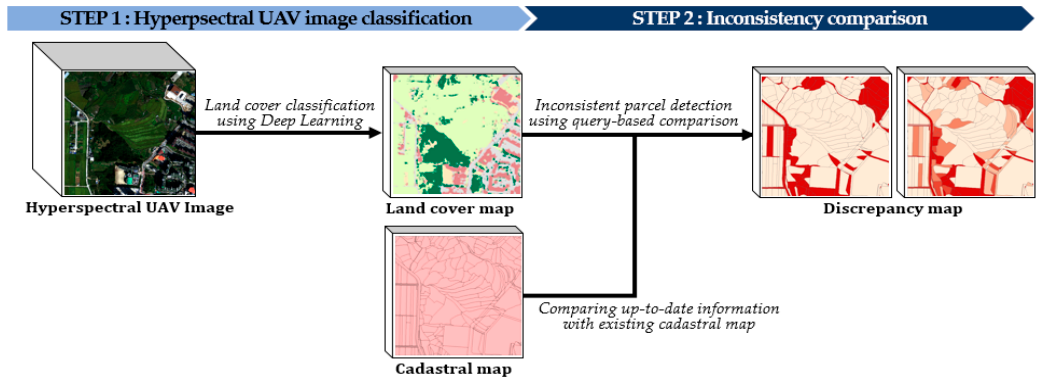
Figure 1. Proposed process of discrepancy analysis. UAV: unmanned aerial vehicle.